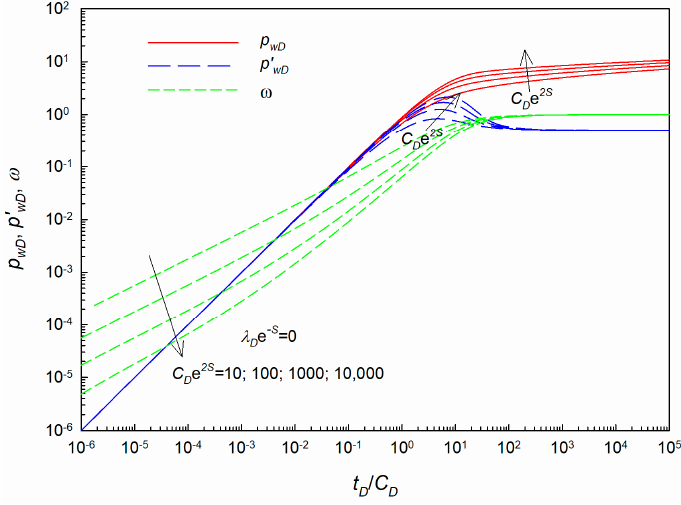
Figure 7. Effect of C D e 2S on the new type curves for Darcy flow model without